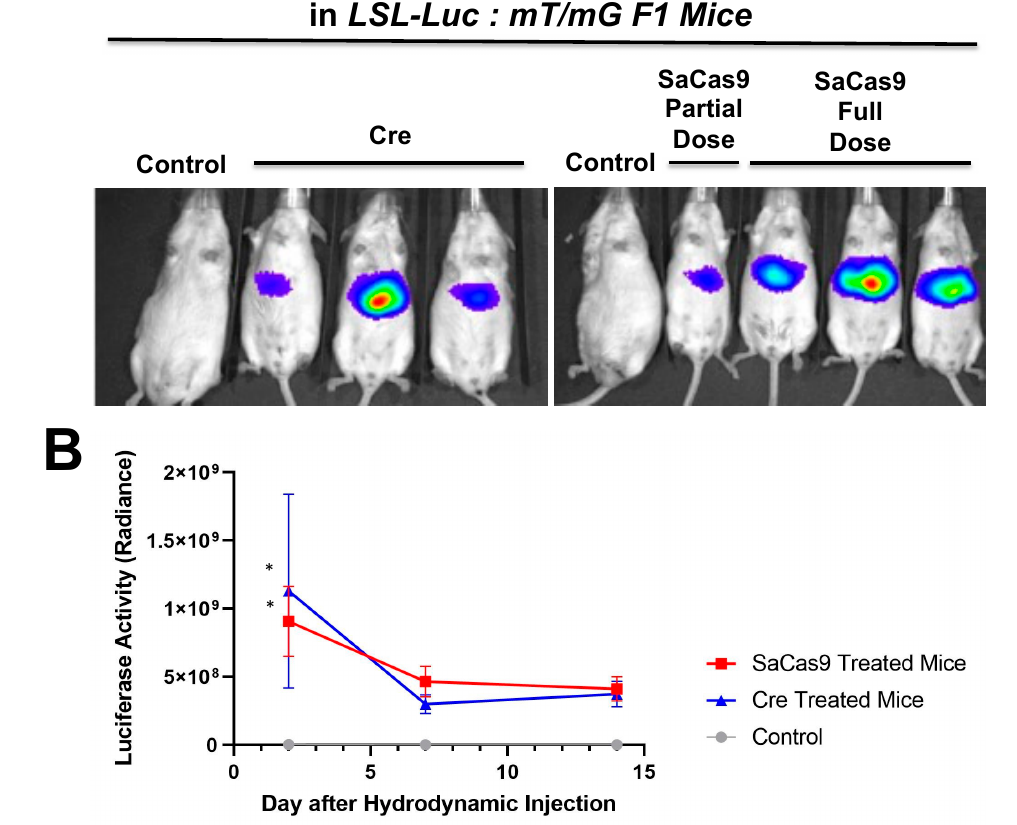
Figure 5. Hydrodynamic delivery in hybrid reporter mice. ( A ) LSL mice were crossed with RG mice to produce a crossed reporter mouse. These mice are sensitive to cre recombinase or CRISPR activity leading to luciferase expression and GFP expression. Mice were hydrodynamically injected with cre recombinase or SaCas9 expressing plasmids. Control mice received a 2.5 mL PBS injection, the SaCas9 plasmid mice received 12.5 µ g of each plasmid in the 2.5 mL of PBS, and the cre groups received 25 µ g of cre plasmid in 2.5 mL of PBS. ( B ) Luciferase activity was monitored within the mice on days 2, 7, and 14 and t -tests were carried out. Comparing via t -tests showed that the editing groups were significant on Day 2 compared to the control. The lines denote a 95% confidence interval (n = 3) (* p <